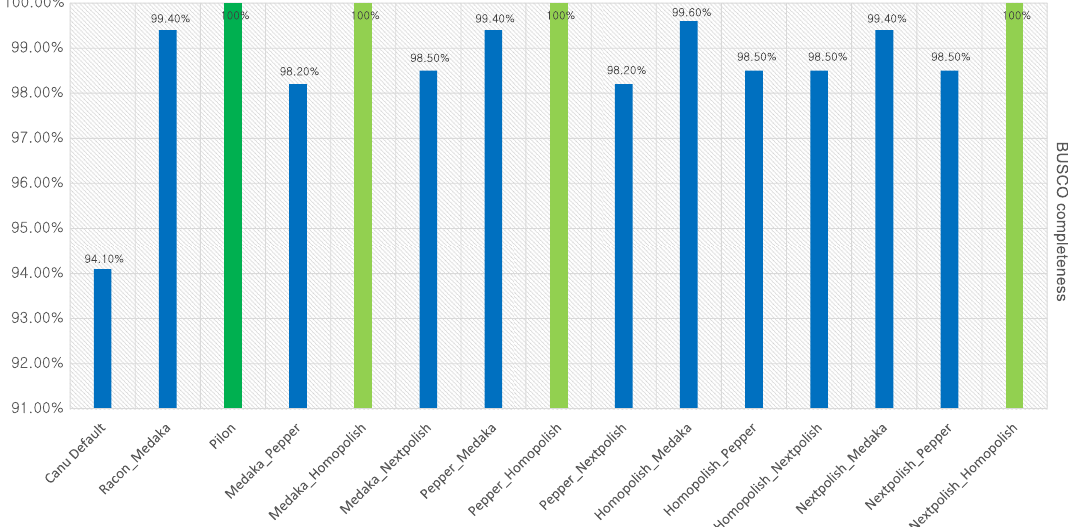
Figure 4. BUSCO evaluation result for combination polishing using enterobacterales_odb10. Bar indicates the completeness of BUSCO. Green color indicates the result of short-read based pilon polishing. Light green color indicates the highest accuracy from Nanopore read based